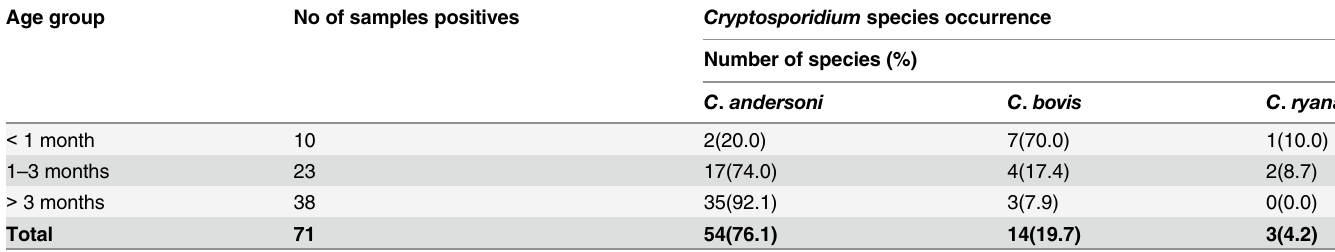
Table 3. Age-related distribution of Cryptosporidium species in calves in central Ethiopia (January — June, 2014).